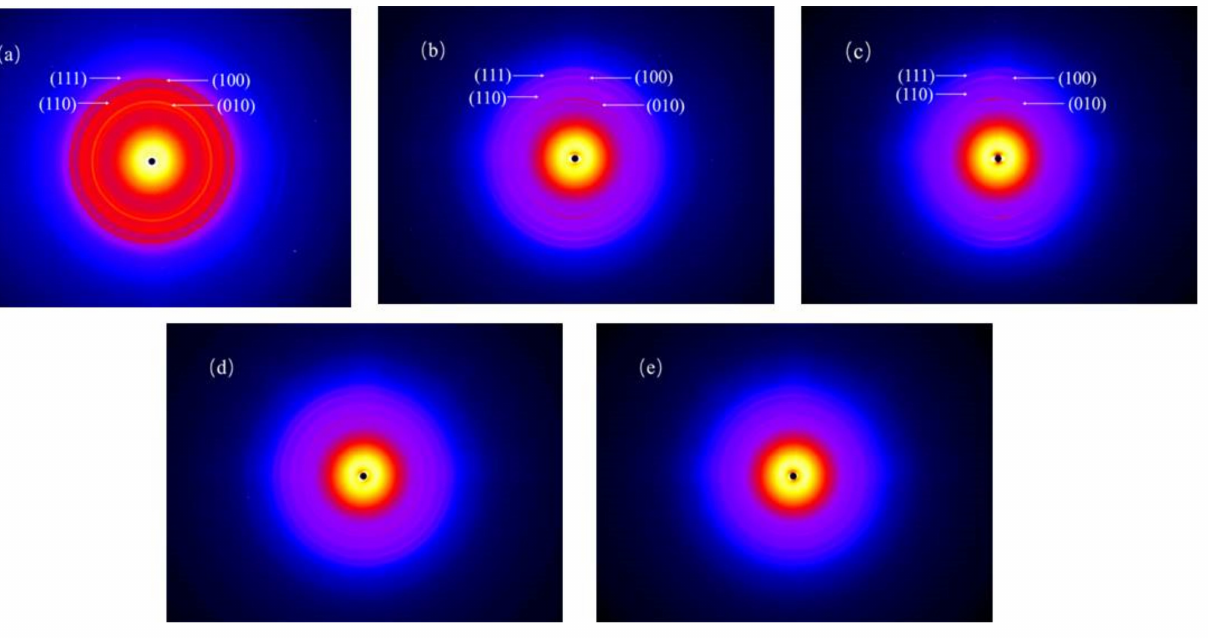
Figure 6. The films of PBAT-1.0 under different biaxial stretching ratio (transverse direction × machine direction). ( a ) 1 × 1, ( b ) 1 × 2, ( c ) 1 × 3, ( d ) 1.5 × 1.5, and ( e ) 2 ×